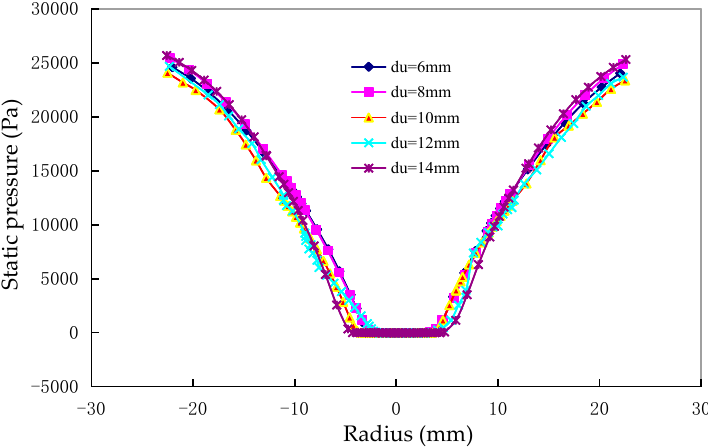
Figure 8. Static pressure profiles at several underflow pipe diameters.